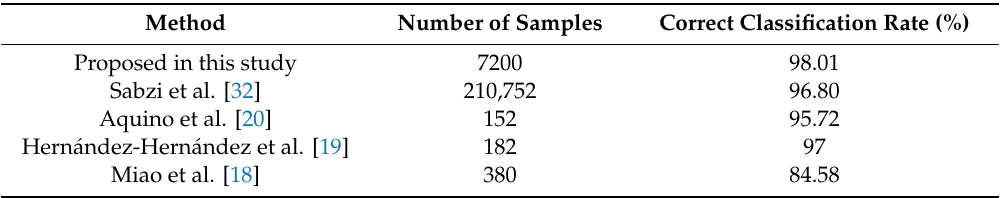
Table 15. Comparison of di ff erent studies in the field of segmentation with the proposed method in this